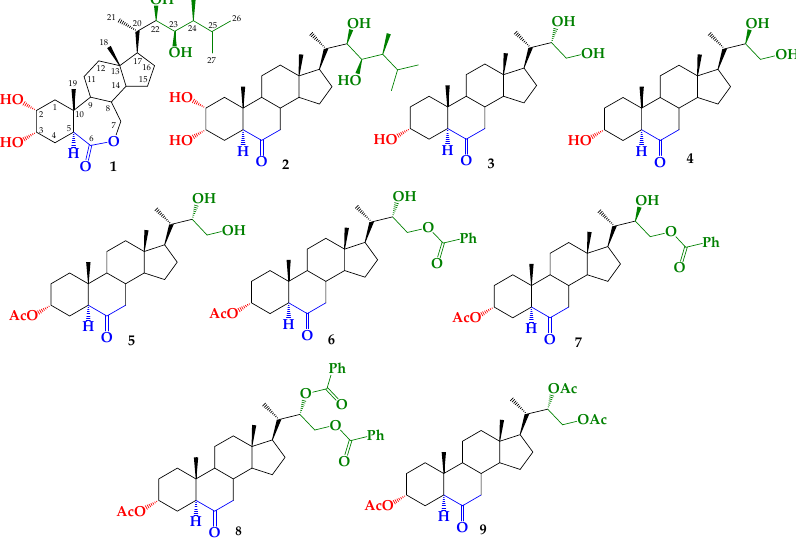
Figure 1. Structure of brassinolide (BL) ( 1 ), castasterone (CS) ( 2 ) and synthetic brassinosteroids (BRs) 24 ‐ nor ‐ 5 α‐ cholan type analogs 3 – 9 .